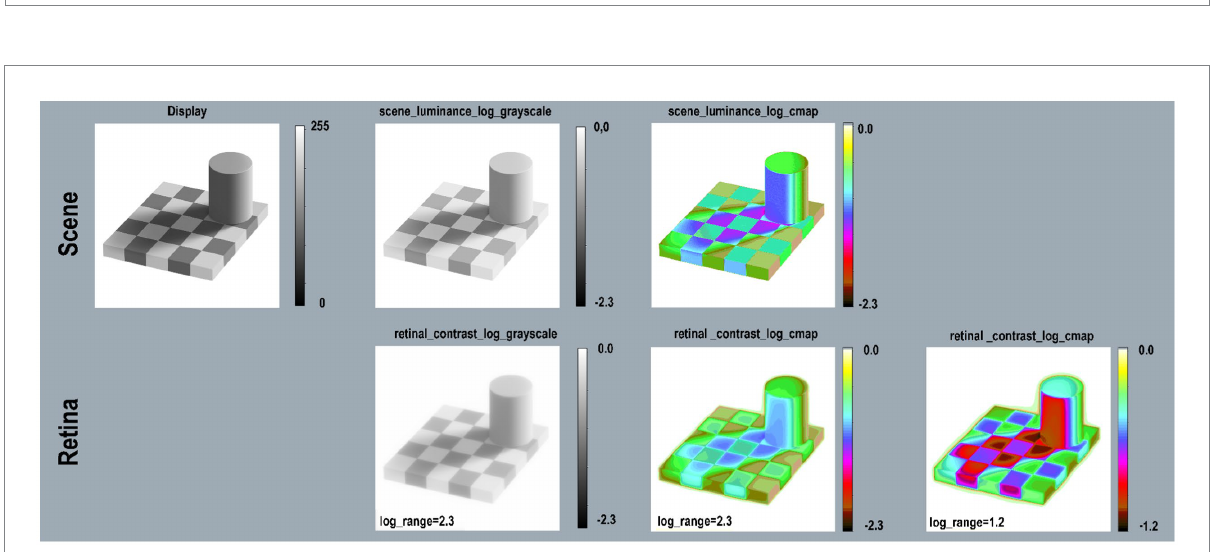
FIGURE 11 Checkershadow Illusion—Scene (top-row) reproduces the image on the display; scene_luminance_log_grayscale; and log_cmap. Retina (bottom- row) retinal_contrast using the same mapping. All calculations used parameters: pseudocolor [ cmap.LUT ], [ padding = replicate ]. The first three columns used [ log_range = 2.3 ]. The extended White surround for the Tower and Checkerboard raised the mean retinal contrast values and reduced the total [ log_range = 1.2]. The final column on the right used [ log_range = 1.2 ] to get a better rendition of retinal_contrast values in this illusion.